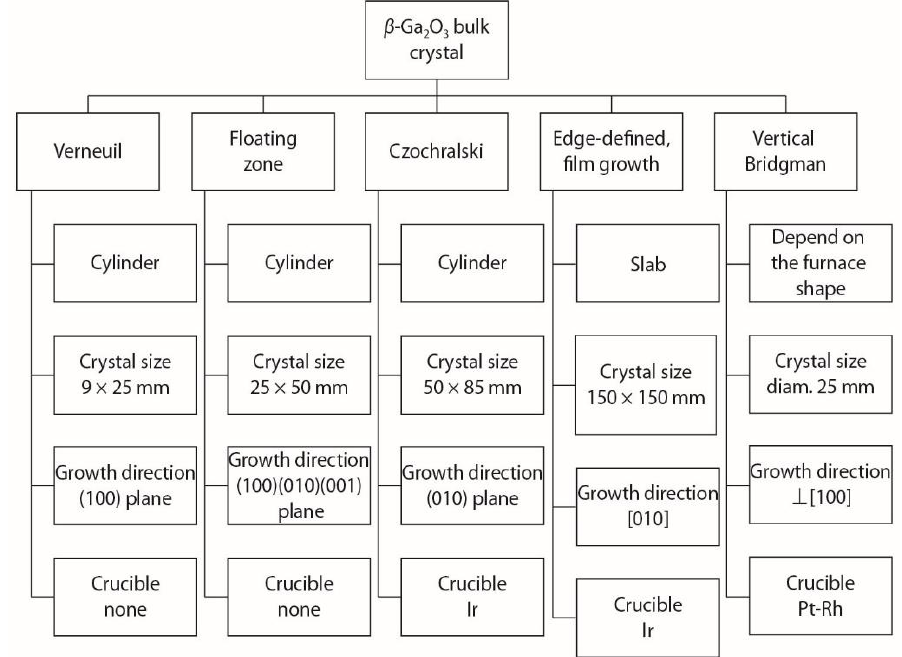
Figure 4. The various techniques for the growth of bulk β -Ga 2 O 3 crystals [78]. “Reprinted with permission from Ref. [78]. Copyright (2019), IOP Science”.